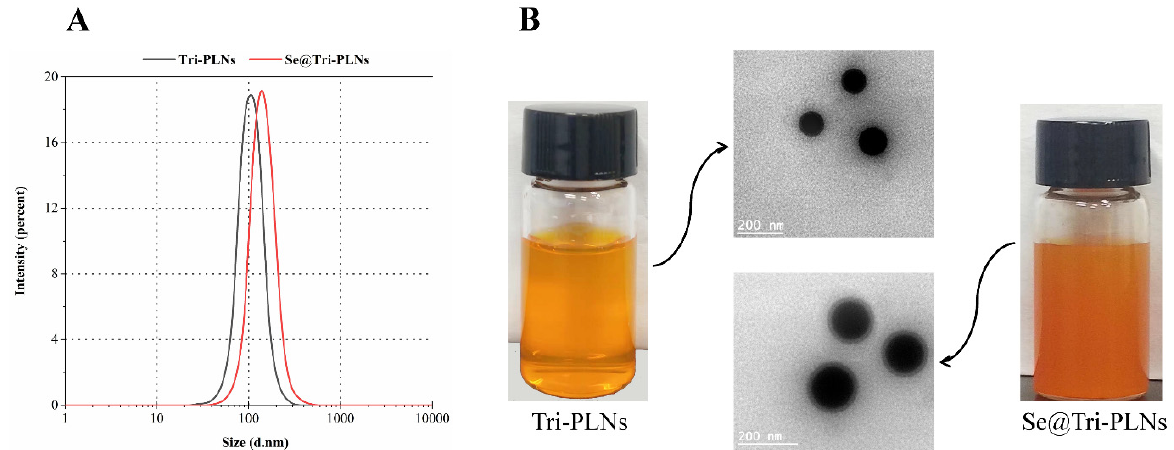
Figure 3. Characterization of Tri-PLNs and Se@Tri-PLNs by particle size distribution ( A ) and appearance/TEM micrographs ( B ).